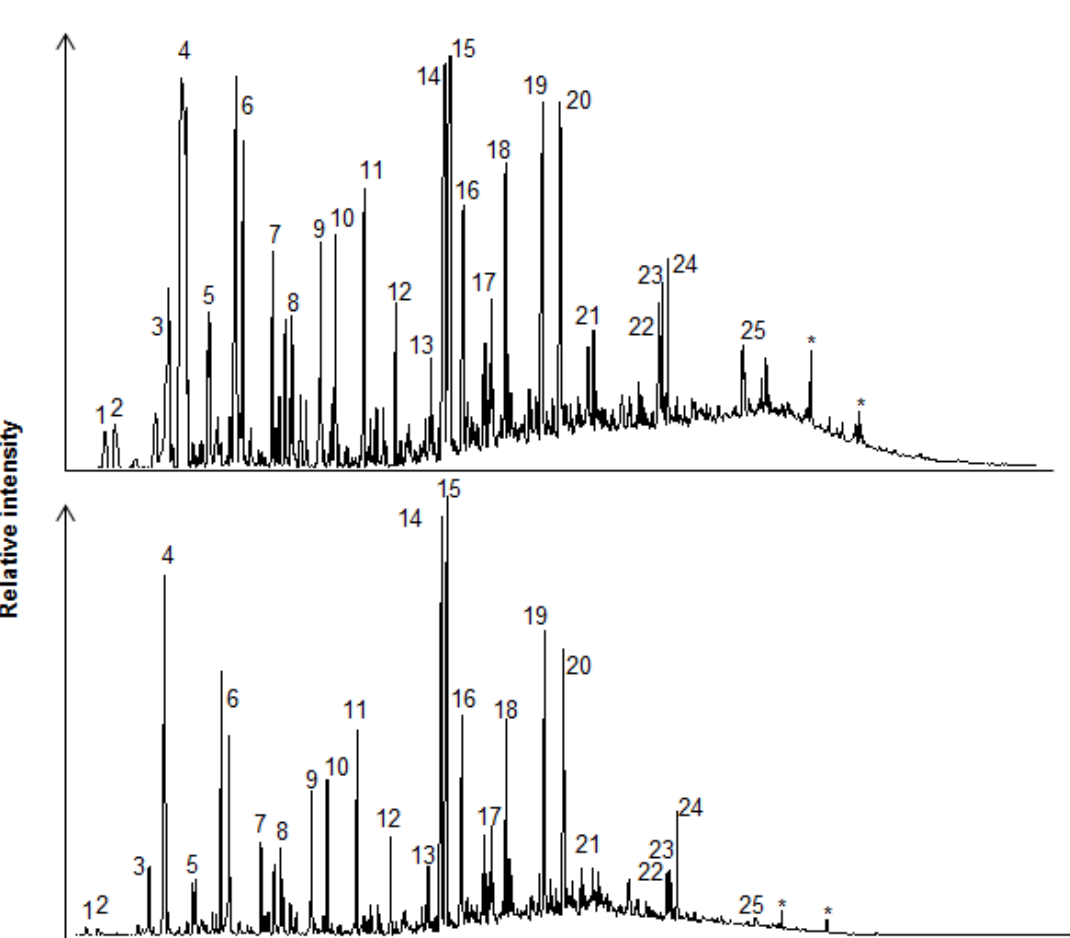
Figure 4. Total ion chromatogram (TIC) of the contaminants mixture of the study soil at the beginning (top) and after 15 days of treatment (bottom; control treatment). (1) Indene; (2) Methyl-phenol; (3) Cresols; (4) Naphthalene; (5) Quinoline; (6) C1-Alkylnaphthalenes; (7) Biphenyl; (8) C2-